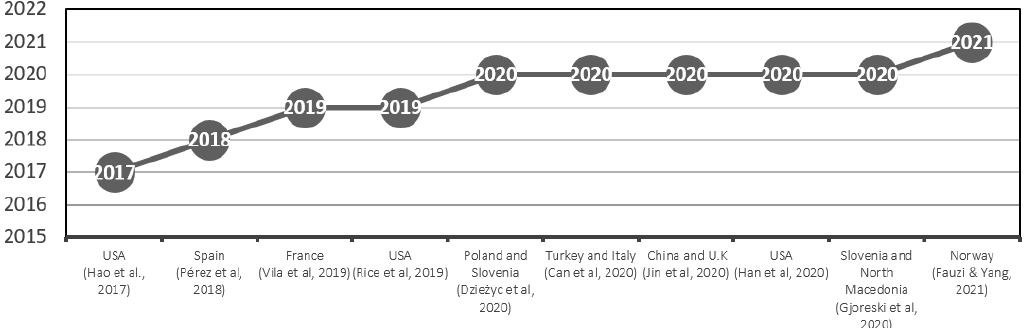
Figure 2. Synthesis of distribution of included papers considering a timeline and their countries. The x-axis represents country and reference, and y-axis the publication year. The dots indicate the